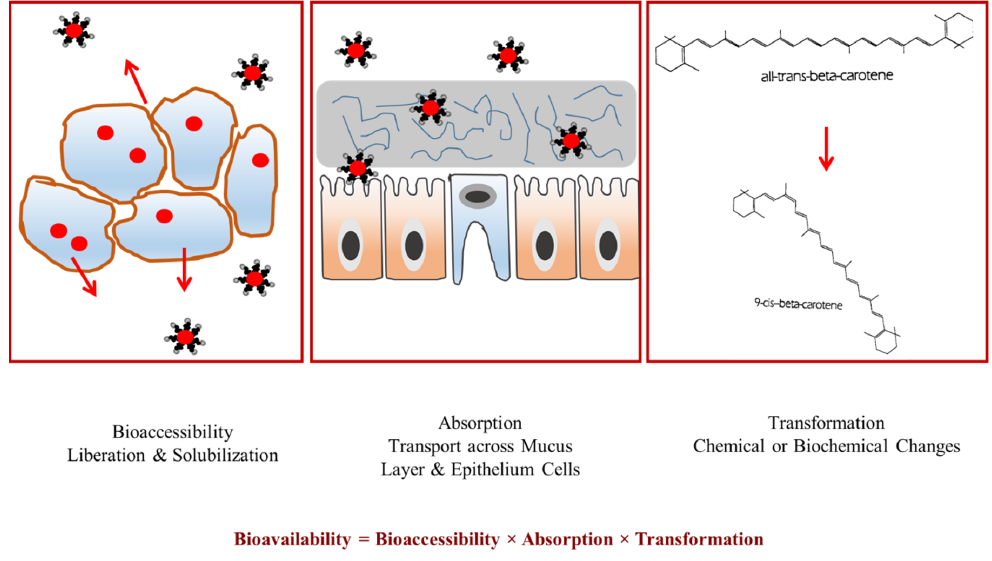
Figure 2. The overall oral bioavailability of bioactives is governed by three main factors: bioaccessibility; absorption; and transformation.